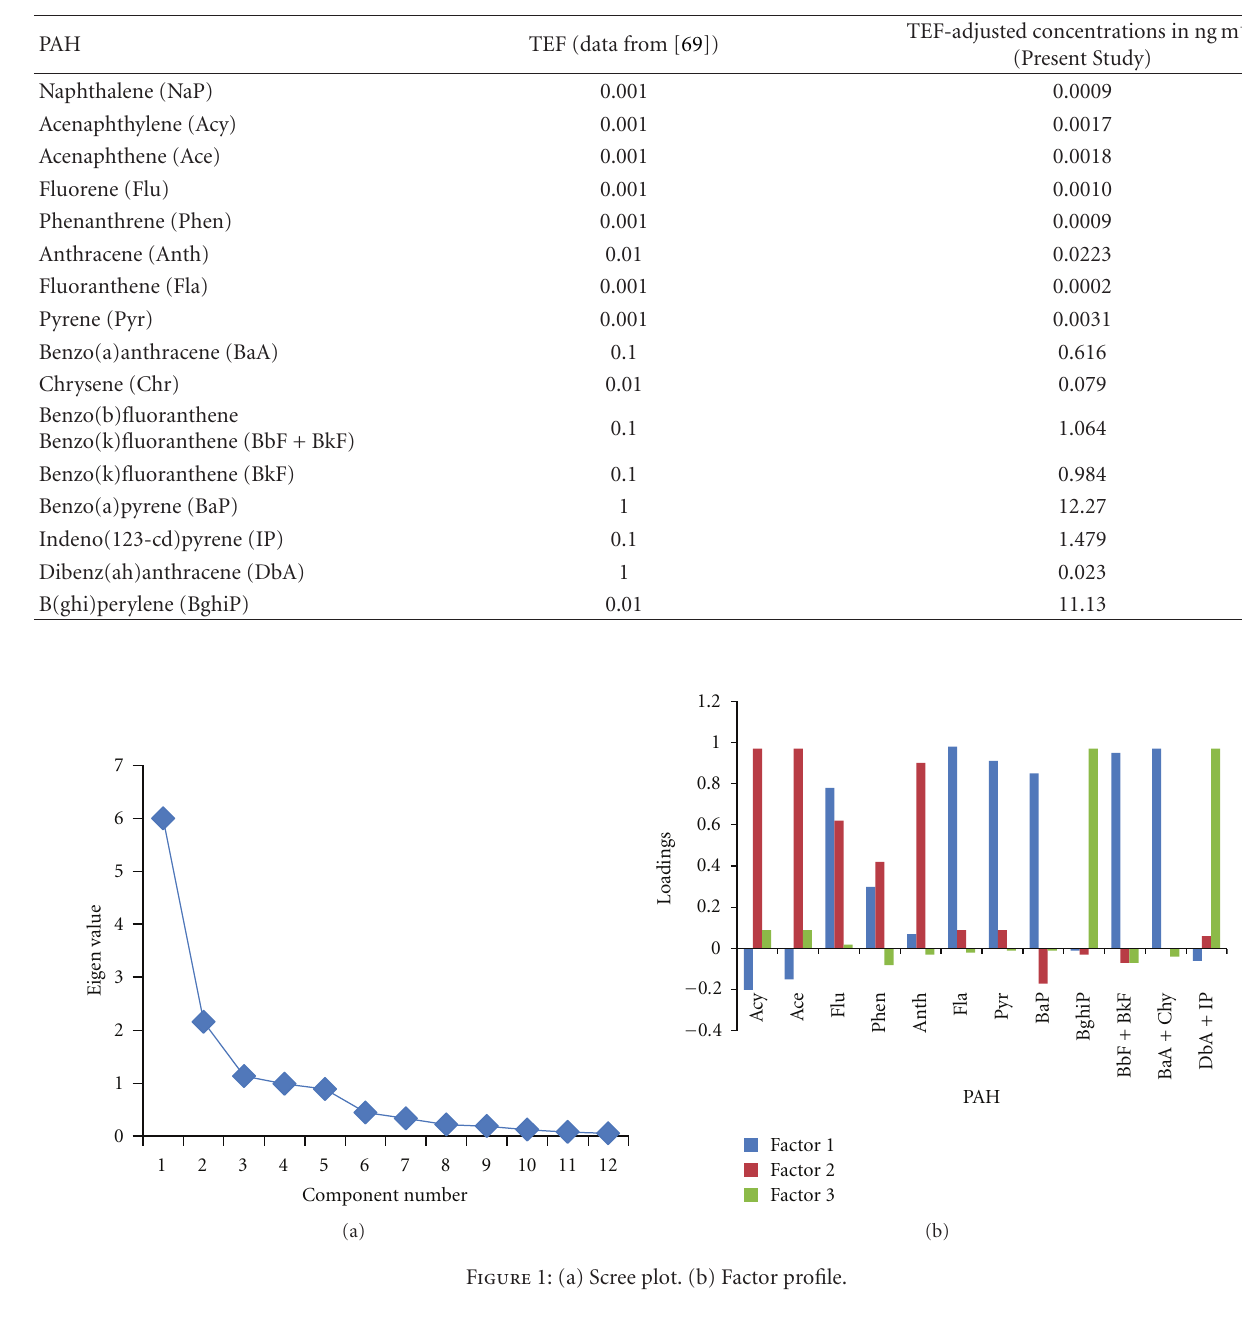
Table 4: Proposed Toxic Equivalency Factors (TEFs) for individual PAHs and calculated TEF-adjusted concentrations of measured samples.